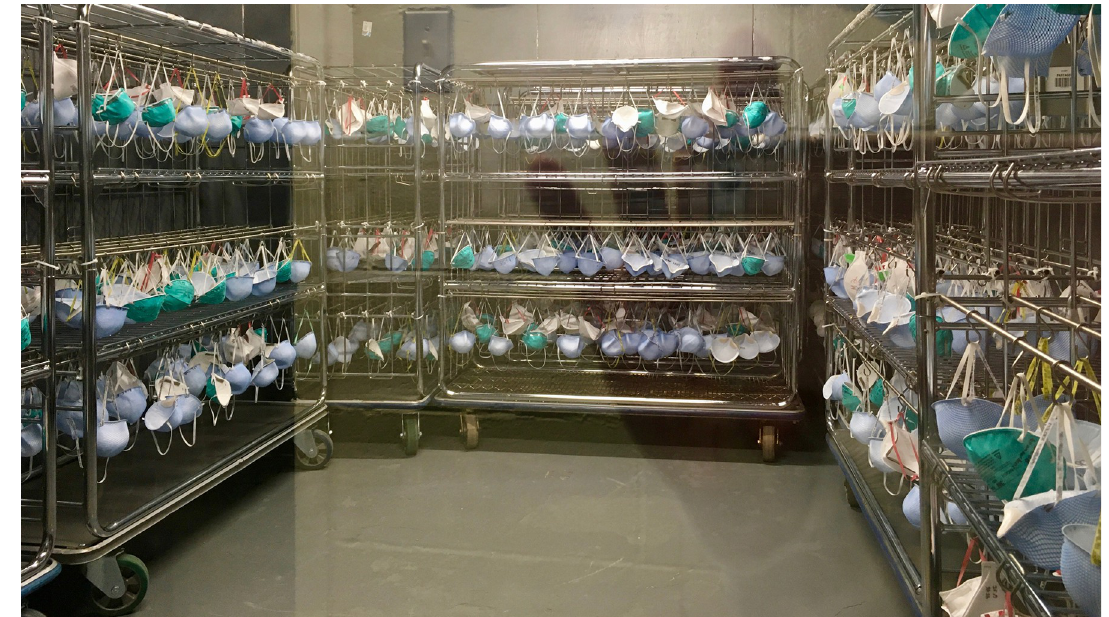
Fig 3. A 40-m 3 decontamination room with 8 metal racks equipped with hooks, used for large-scale implementation of FFR treatment at the